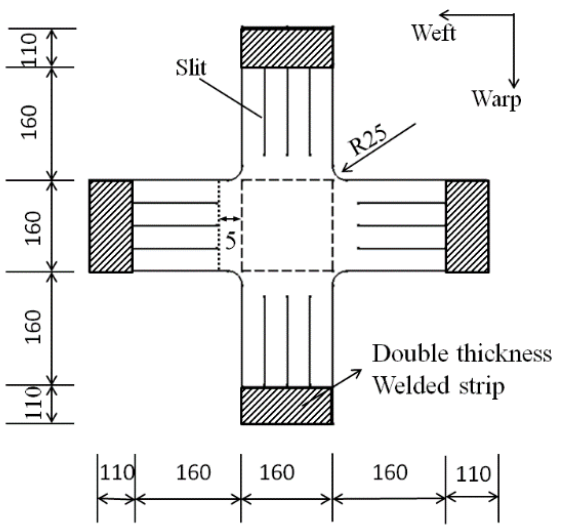
Figure 3. Dimensions of the specimen for biaxial tensile tests (unit in mm).